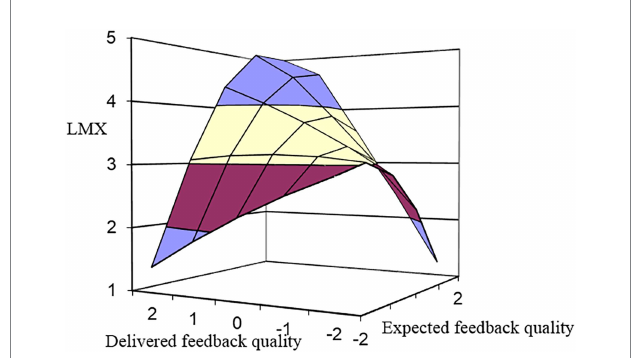
FIGURE 2 Direct effect of expected-delivered feedback quality congruence on leader-member exchange